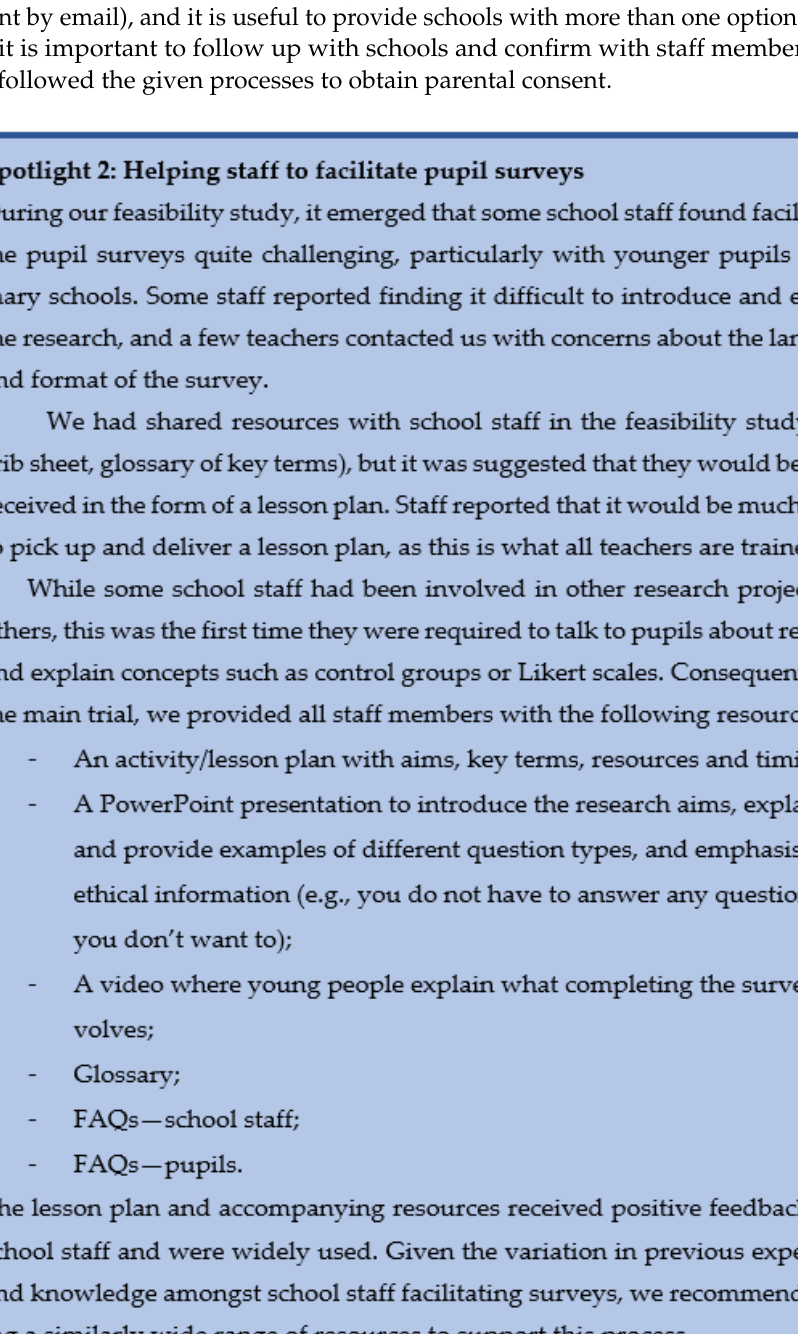
Figure 2. Spotlight on helping staff to facilitate pupil